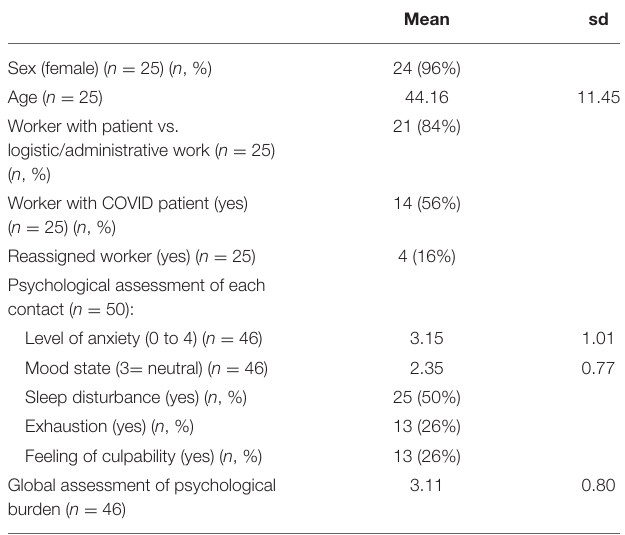
TABLE 1 | Characteristics of the